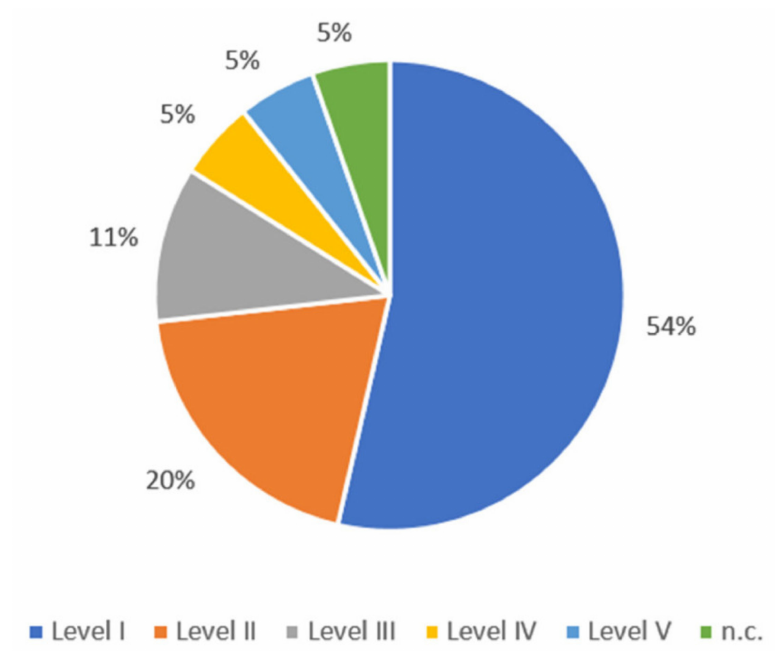
Figure 4. Distribution of children reached by the survey according to their GMFCS.